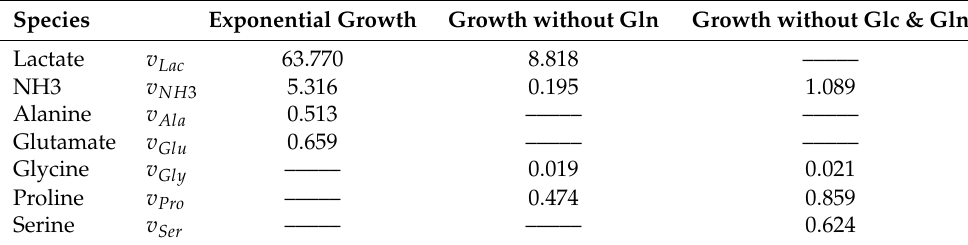
Table 4. Specific excretion rates ( µ M/d × 10 7 cell) Lactate, NH3 and non-essential